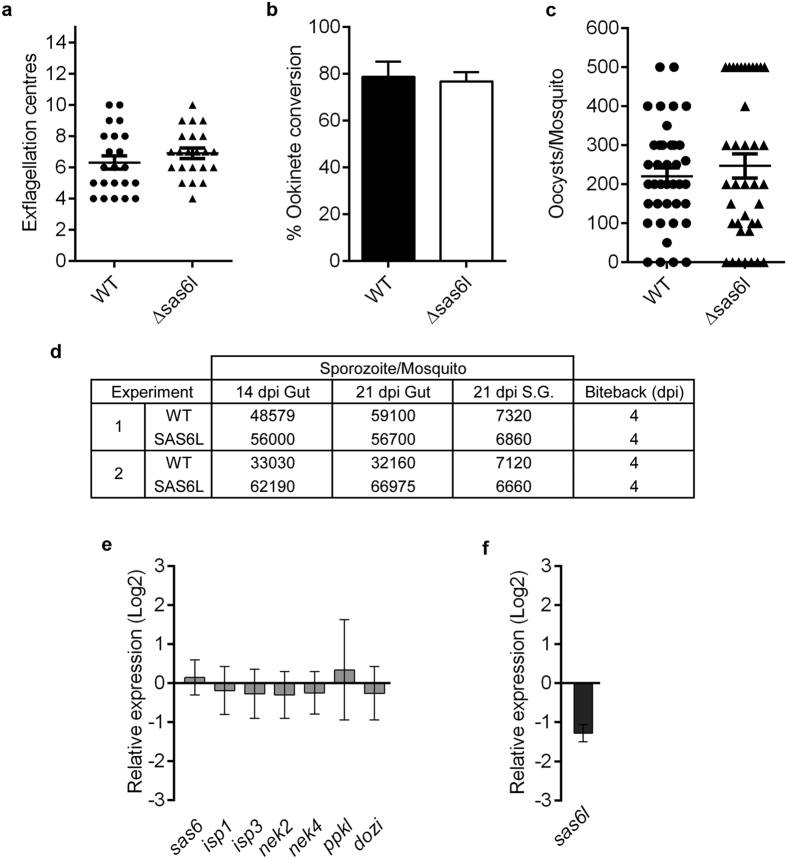
Gene deletion shows that sas6l is not essential in parasite development and transmission.(a) Microgametogenesis of ∆sas6l in comparison to WT measured as the number of exflagellation centres per field. Means ± SEM are shown. n = 22 from three independent experiments (cl. 2 = 2 experiments; cl. 3 = 1 experiment). (b) Ookinete conversion as a percentage in ∆sas6l and WT lines. Ookinetes were identified using the marker 13.1 and were defined as those cells that successfully differentiated into elongated ‘banana shaped’ ookinetes. Bar is the mean ± SEM. n = 4 (cl. 2 = 3; cl. 3 = 1) independent experiments. (c) Oocysts per mosquito gut (14 days post-infection; bar = arithmetic mean ± SEM; n = 38 from three independent experiments. (cl. 2 = 2 experiments; cl. 3 = 1 experiment) of Δsas6l or WT parasite-infected mosquitoes. An infection rate of >80% was observed for both Δsas6l and WT parasites. (d) Sporozoites per mosquito for 14 and 21 dpi and bite-back experiments indicating successful transmission of both Δsas6l and WT parasites from mosquito to mouse. Infected mosquitoes were allowed to feed and the mice were monitored for blood stage parasitaemia (days post infection, dpi) indicative of successful liver and blood stage infection. Example of two independent experiments (cl. 2 and cl. 3) are shown. (e) Relative expression of sas6, sas6l, isp1, isp3, nek2, nek4, ppkl RNA in Δsas6l parasites and (f), sas6l RNA level in Δdozi mutant parasites compared to WT controls (∆∆Ct method). Mean ± SEM, n = 3 biological replicates from at least two independent experiments. One representative experiment is shown.